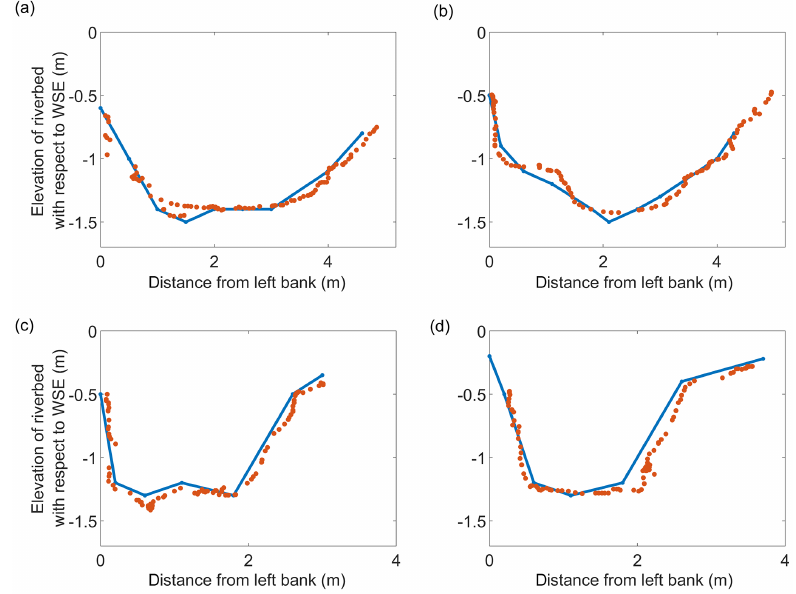
Figure 11. River-cross-section observations retrieved from Marrebæk Kanal at the locations shown in Fig. 10 after bias correction of the Deeper sonar observations. Red points are retrieved with UAV-borne observations and blue lines are the ground truth observations.